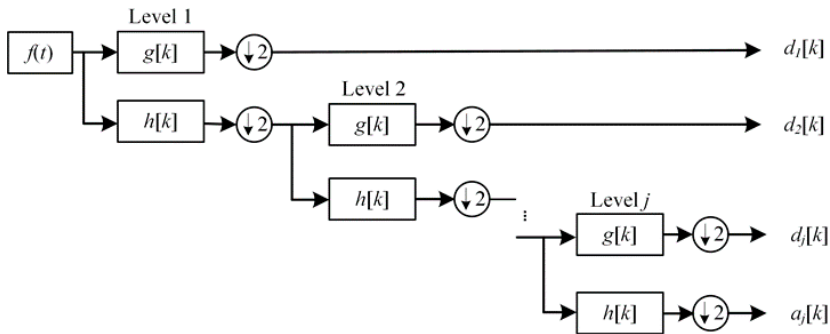
Figure 1. Schematic diagram of multiple resolution analysis (MRA).